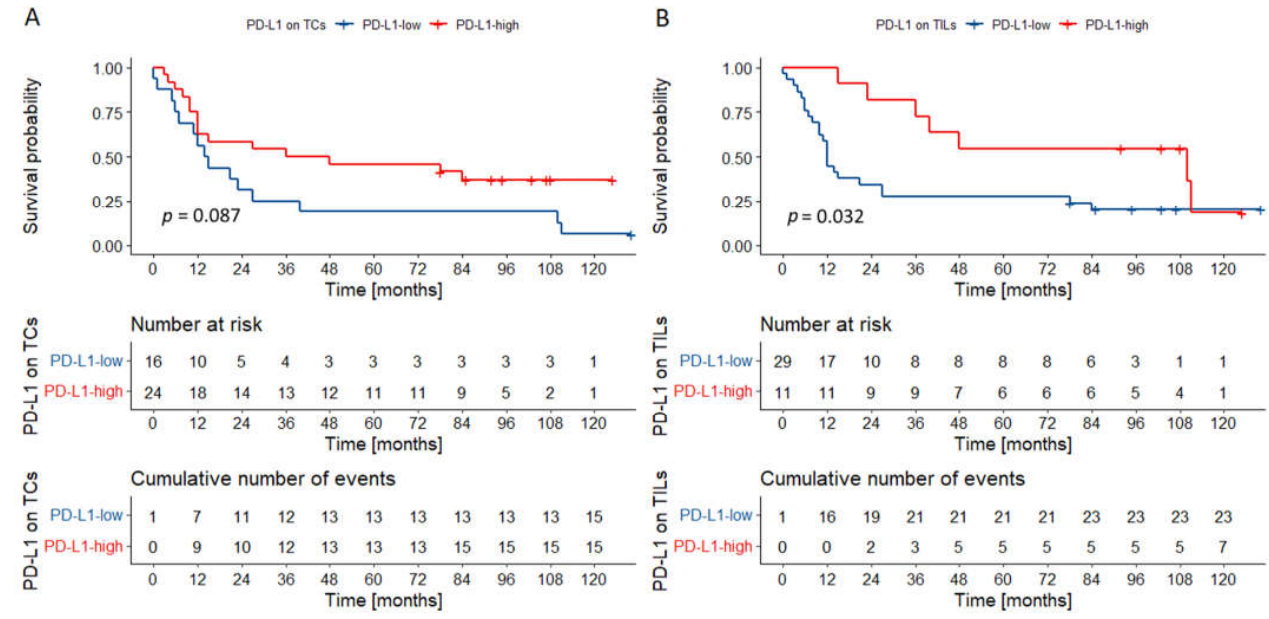
Figure 6. Overall survival probability curves according to PD-L1 expression on TCs ( A ) and TILs ( B ) in other oral compartments. There was a trend toward better survival in tumors characterized by high PD-L1 expression on TCs. Tumors rich in PD-L1-positive TILs had superior outcomes. p values were calculated with the log-rank test. Abbreviations: TCs—tumor cells; TILs—tumor infiltrating lymphocytes.